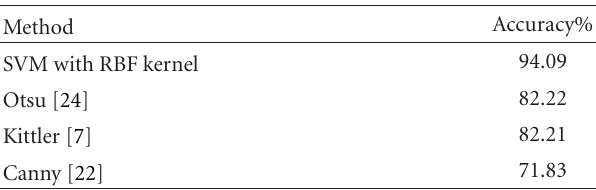
Table 4: Comparison between SVM and di ff erent conventional methods. Here the number of training pixels was 3844 with 2 classes, and the number of test pixels was